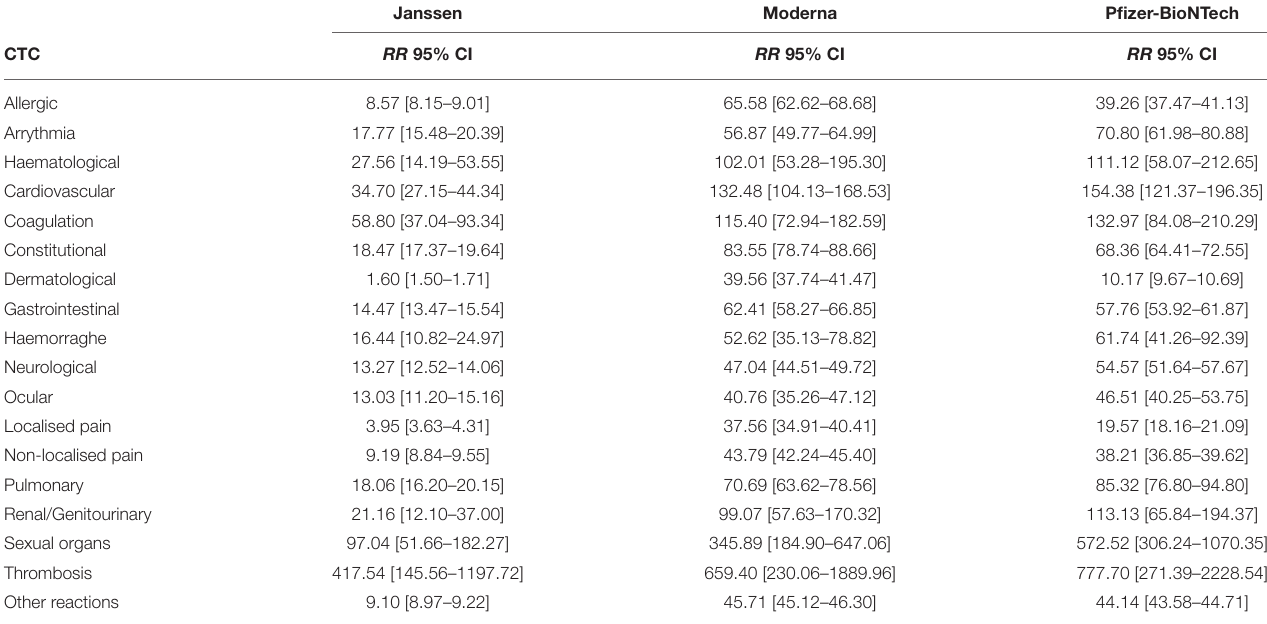
TABLE 3b | Vaccine-related relative risk estimates (RR) and 99% confidence intervals (CI) by Common Toxicity Criteria (CTC) in the VAERS